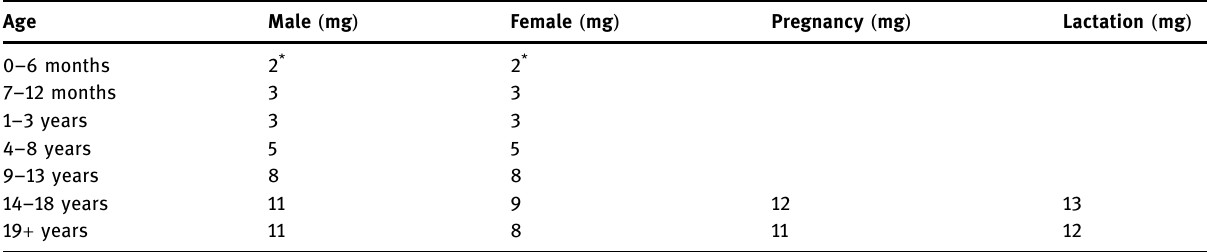
* Adequate intake ( AI )